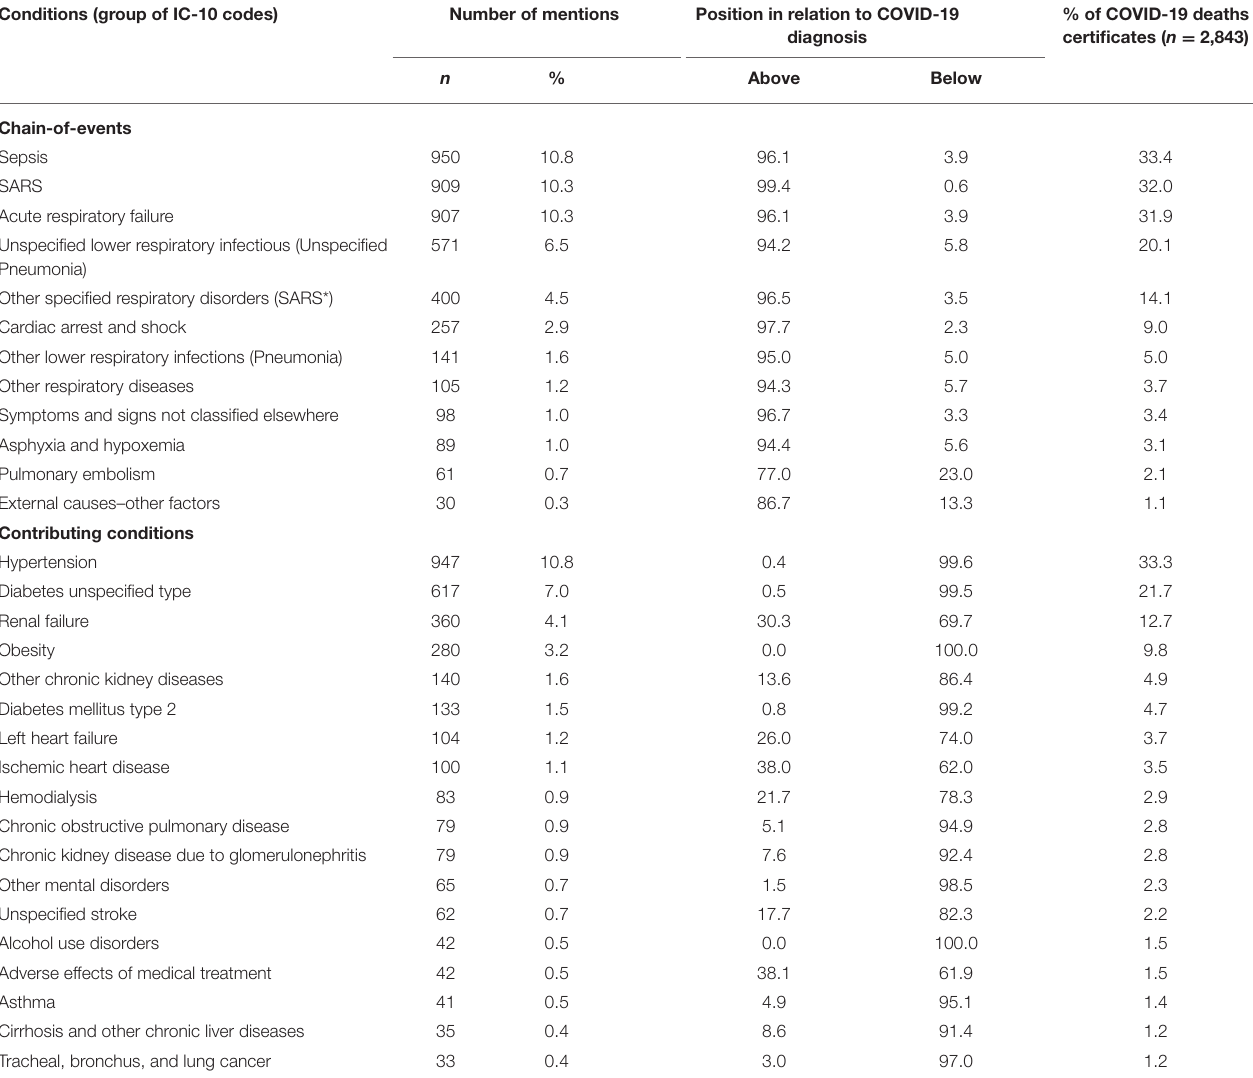
TABLE 2 | Most frequent conditions listed in death certificates by position in relation to COVID-19 diagnosis, at ages 30–69 years, in three Brazilian capitals, 2020. Conditions (group of IC-10 codes) Number of mentions Position in relation to COVID-19